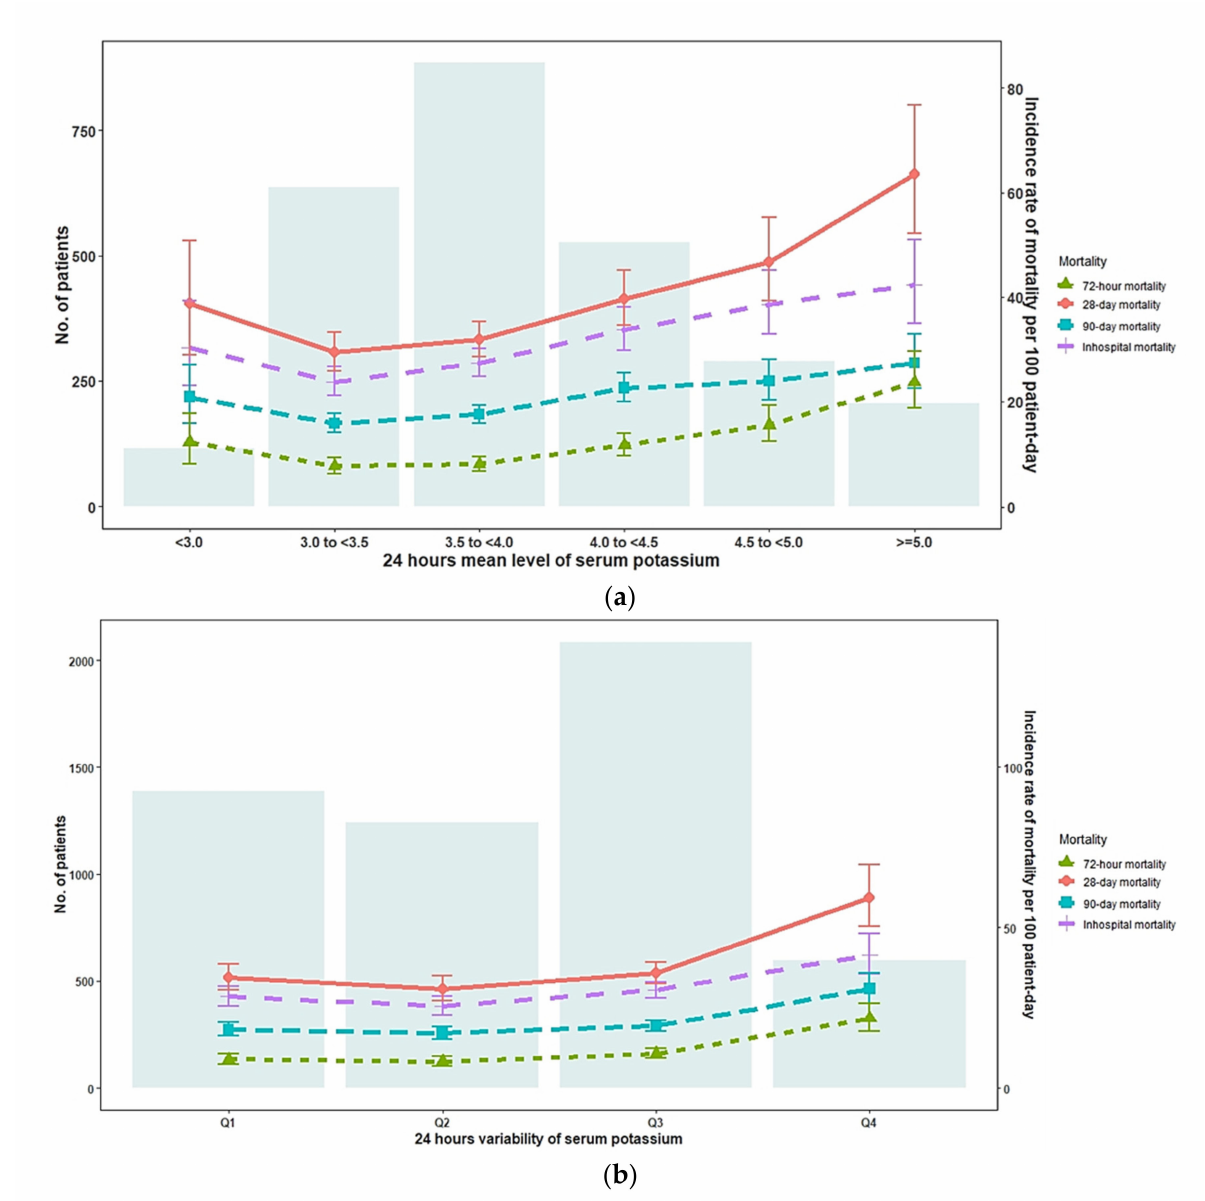
Figure 2. The distribution of serum (K+) level and serum (K+) variability within 24 h after initial CRRT and corresponding mortality rate. ( a ) serum (K+) level within 24 h after initial CRRT; ( b ) serum (K+) variability within 24 h after initial